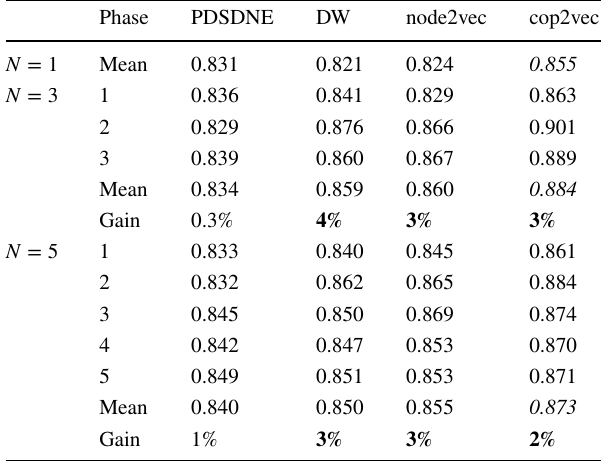
Table 4 Area under curve (AUC) scores for phased co-purchaser pre-